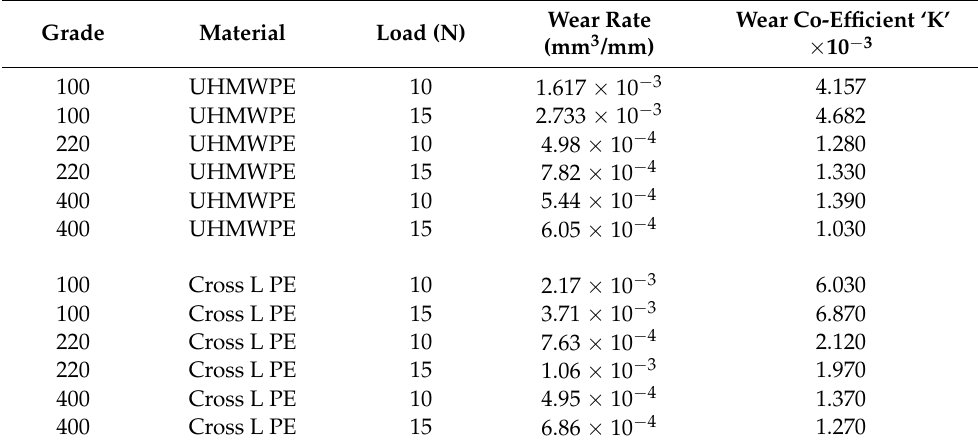
Table 2. The value of K for both materials under various wear